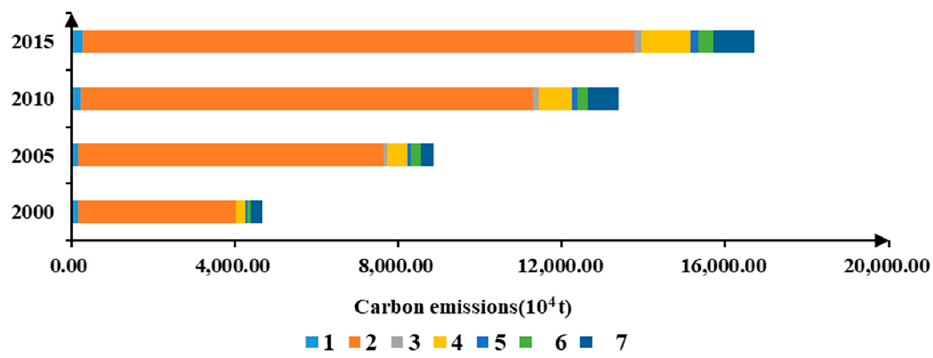
Figure 6. Carbon emissions related to energy consumption in different sectors.